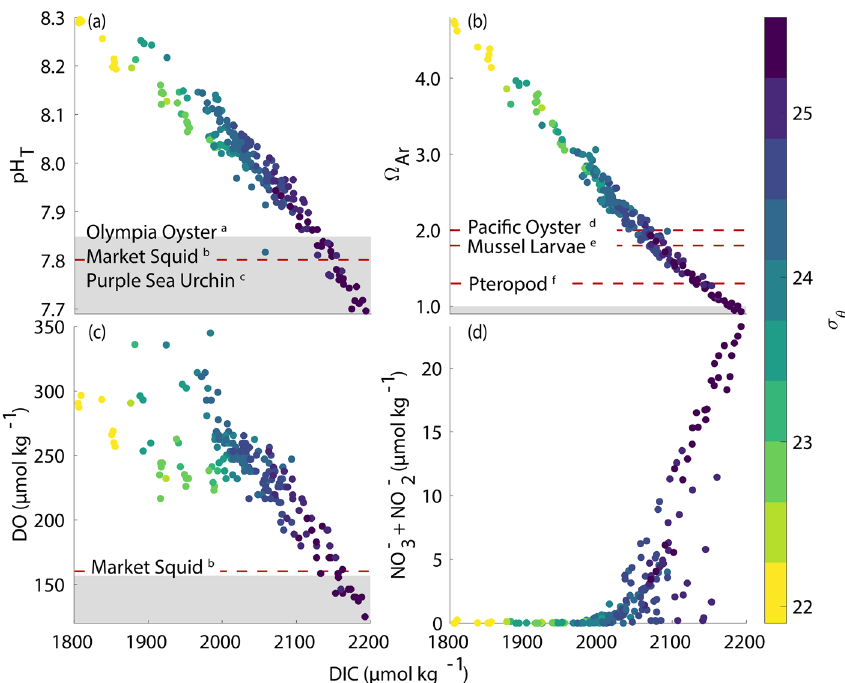
Figure 3. Property-property plots of pH T , Ω Ar , DO, and [NO 3 − + NO 2 − ] as a function of DIC colored by seawater σ θ from all discrete seawater samples. Grey regions in a, b, and c signify mid-century mean oceanic pH T = 7.85 for SSP-5-8.5 ( a ), Ω Ar < 1 ( b ), and sublethal hypoxic threshold, DO < 157 µmol kg −1 ( c ). Red-dashed lines indicate experimentally observed sensitivity levels for the a : Olympia oyster 52 , b : market squid 43 , c : purple sea urchin 53–55 , d : Pacific oyster 58 , e : California mussel larvae 57 , and f : pteropods 56 , i.e., at these levels, some form of negative effect on the organisms fitness was